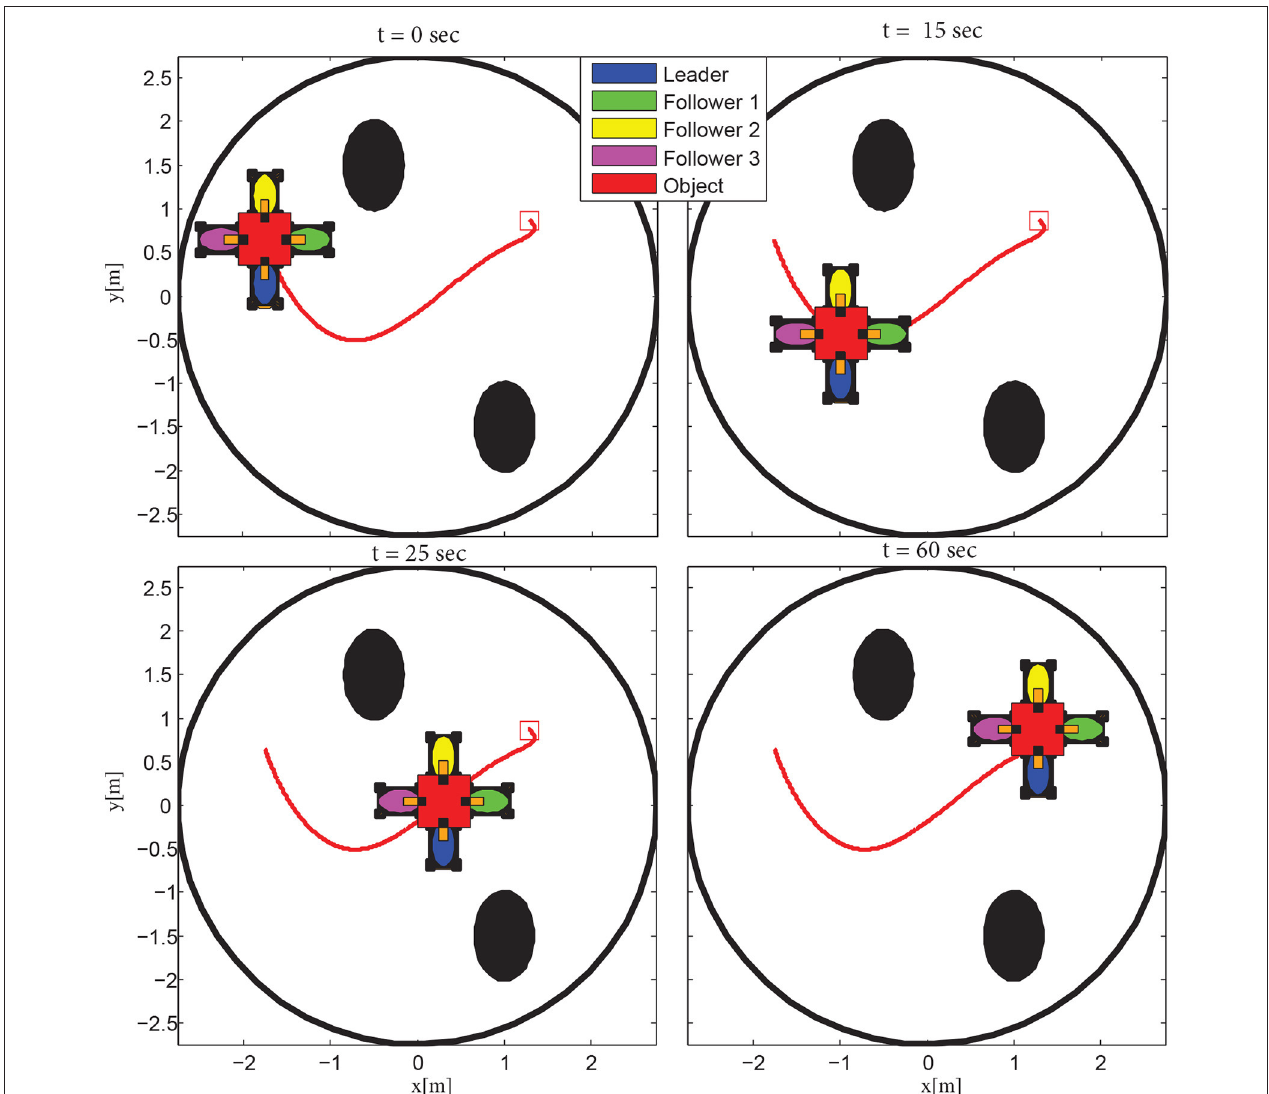
FIGURE 6 | The evolution of the proposed methodology in four consecutive time